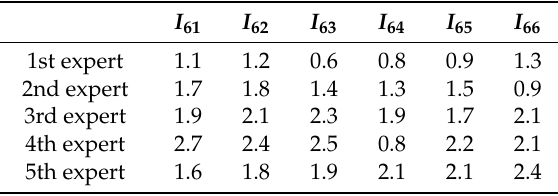
Table A22. Scores of environmental management maturity in the synergy process